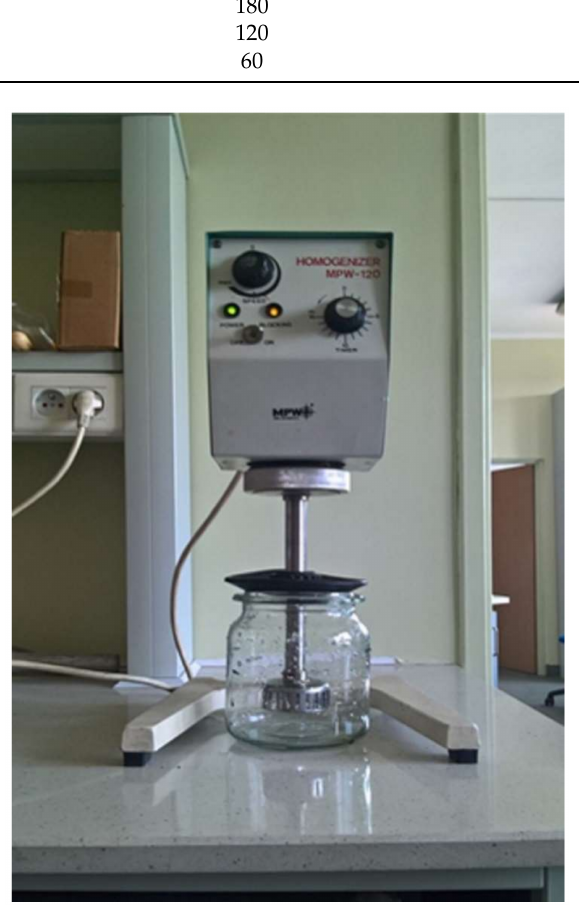
Figure 1. Laboratory scale homogenizing mixer setup—sludge mixer, stand, control